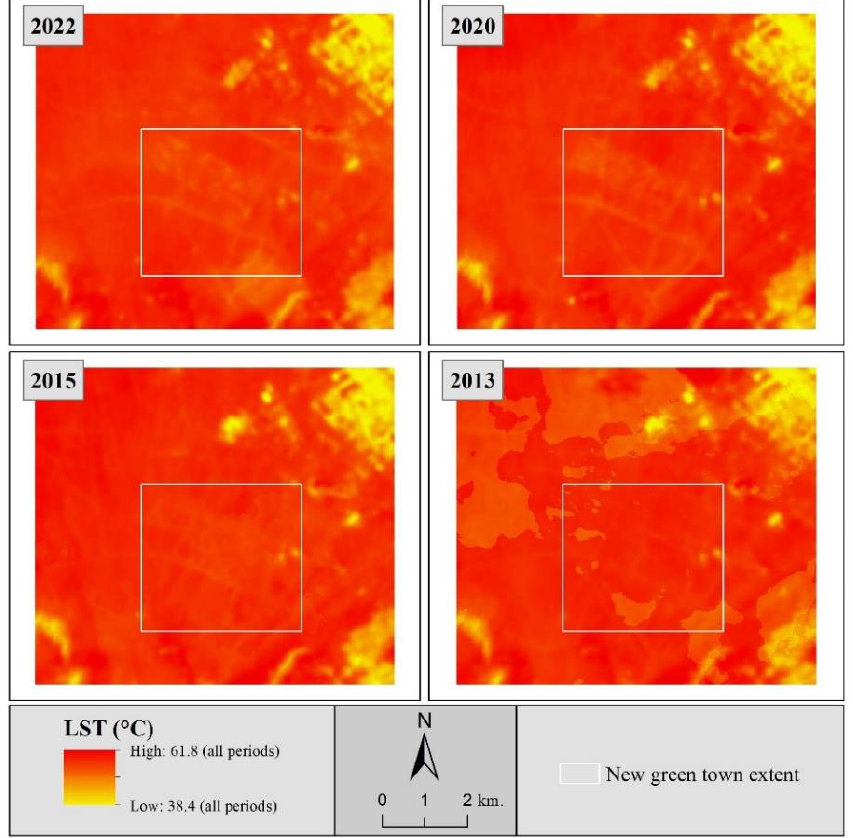
Figure 8. Land surface temperature (LST) maps of the studied area for 2013, 2015, 2020 and 2022.